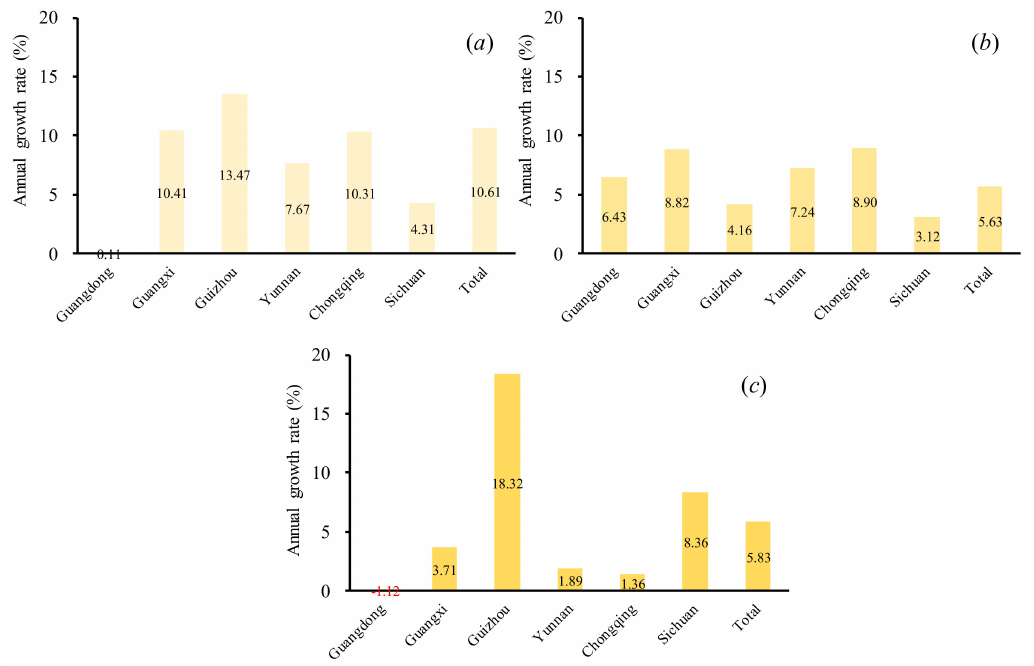
Figure 5. ( a ) The L annual growth rate from 2012 to 2018; ( b ) The M annual growth rate from 2012 to 2018; ( c ) The S annual growth rate from 2012 to 2018. Note: L represents slight karst rocky desertification; M represents moderate karst rocky desertification; and S represents severe karst rocky